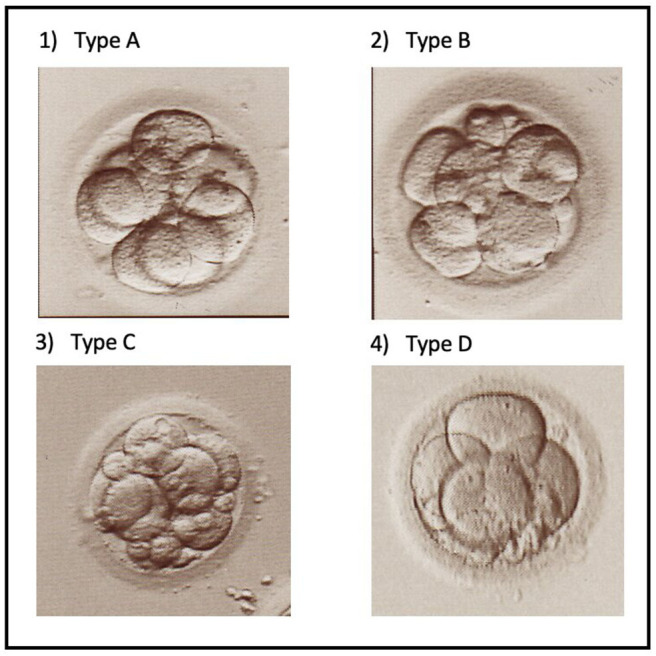
Micrographs showing different types of cleaving embryos on day 3 after ICSI. (1) Type A embryo with adequate number of cells of equal size (8) and only a few cell fragments. (2) Type B embryo with adequate number of cells (8) but some of unequal size, and a larger volume occupied by cell fragments. (3) Type C embryo with a lower number of cells (6) and numerous cell fragments. (4) Type D embryo apparently blocked at the 4-cell stage and some cell fragments.